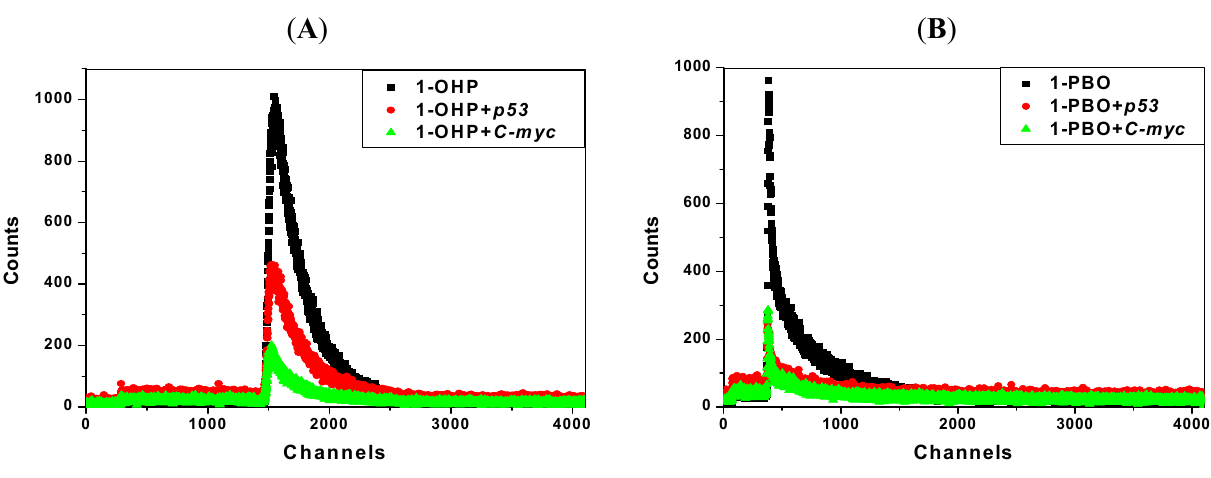
Figure 6. Transient fluorescence spectra of pyrene derivatives (1  mol/L) in the absence and presence of DNA (10  mol/L). ( A ) 1-OHP and ( B ) 1-PBO.